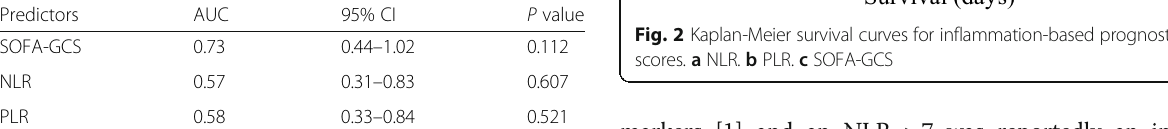
Table 6 Comparison of AUC between predictors Predictors AUC 95% CI P value SOFA-GCS